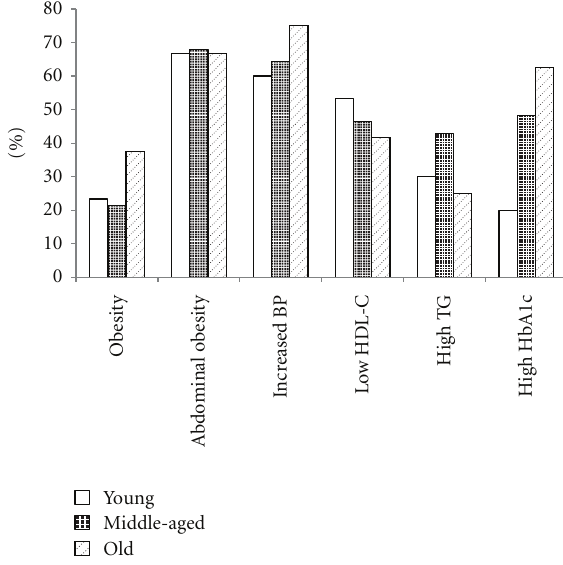
Figure 1: Prevalence of MS risks by age groups. young: under 30 years, middle-aged: 30 to 49 years, Old: 50 years and older. Obesity: BMI ≥ 30, abdominal obesity: ≥ 94 cm for men or ≥ 80 cm for women, Increased BP: ≥ 130 mmHg for systolic or ≥ 85mmHg for diastolic, low HDL-C: < 1.03 mmol/L, high TG: ≥ 1.7 mmol/L, high HbA1c: ≥